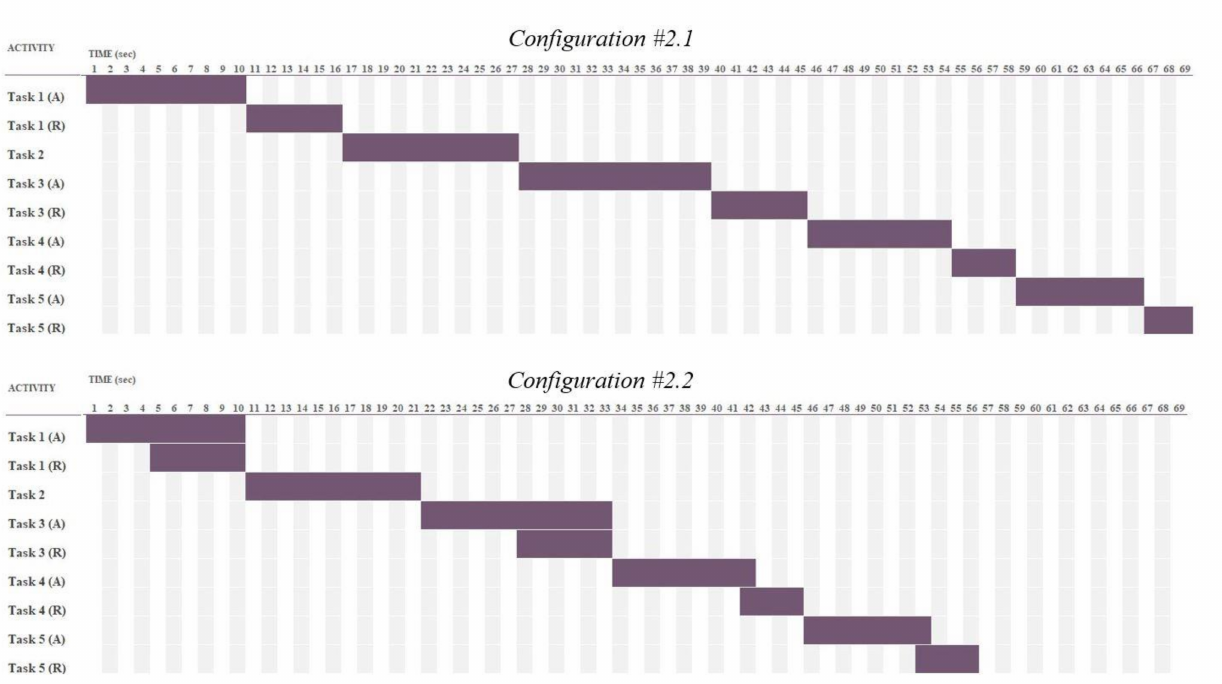
Figure 7. Gantt chart for Configuration #2.1 and Configuration #2.2. (A = Assembly; R =